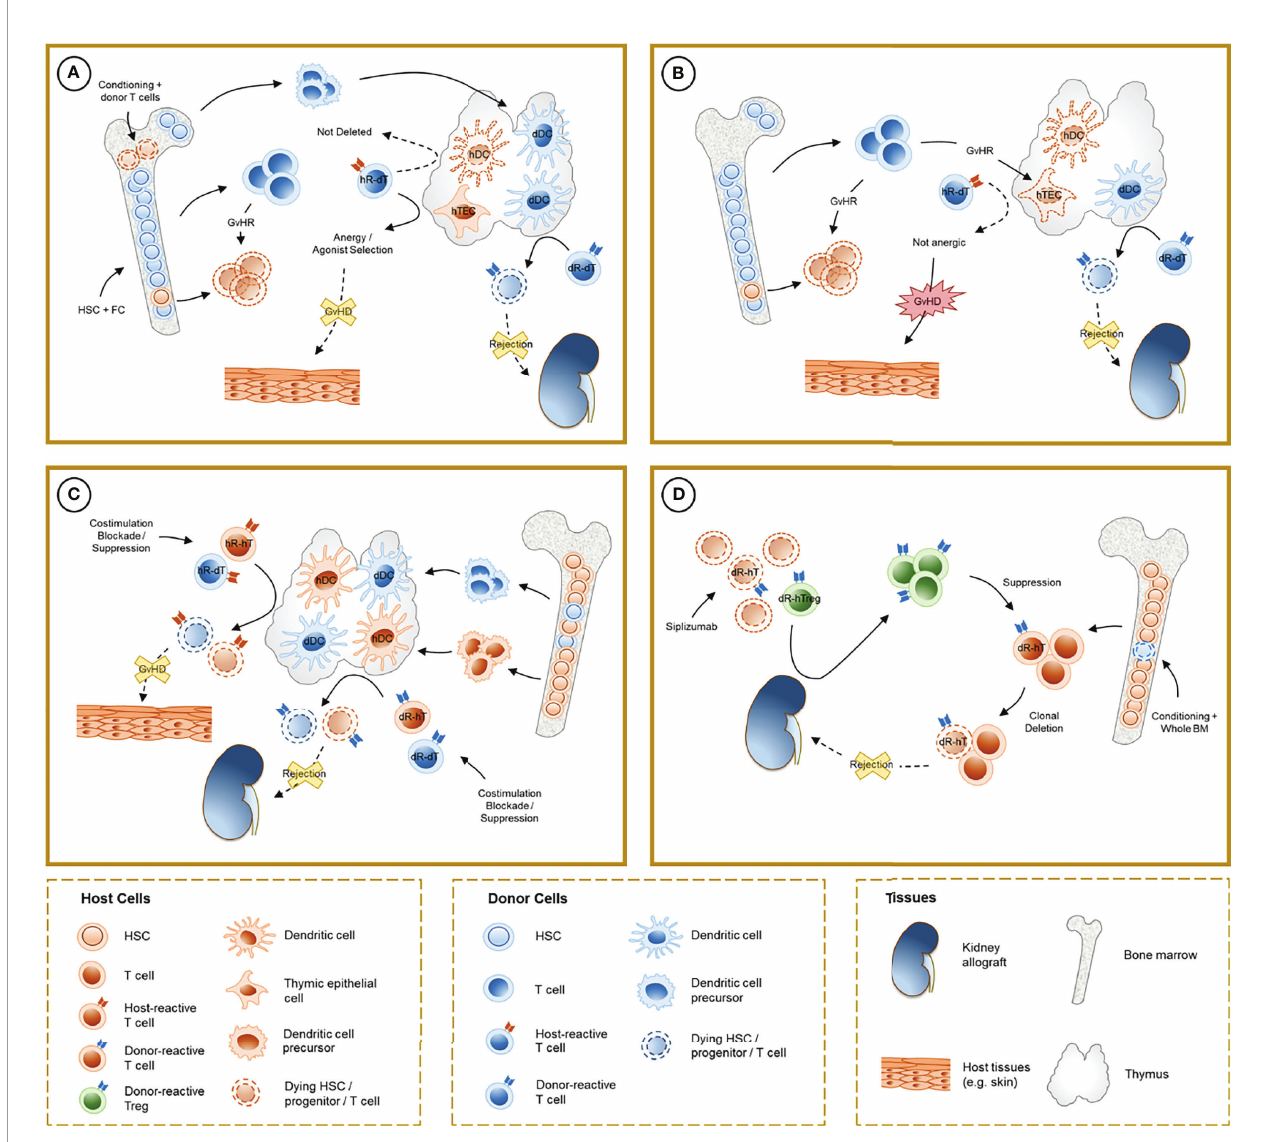
FIGURE 1 | Schematic representation of the mechanisms involved in chimerism-based tolerance to kidney allografts. (A) The induction of full-donor chimerism through hematopoietic stem cell (HSC) infusion along with facilitating cells (FC) after non-myeloablative conditioning results in destruction of host HSC, presumably by graft-versus- host reaction (GvHR) from infused donor T cells, and durable engraftment of donor hematopoietic precursors. After thymic repopulation by donor-derived dendritic cells (dDC), donor-reactive T cells from the donor (dR-dT) undergo clonal deletion in the thymus (central tolerance). Host-reactive donor T cells (hR-dT) are incompletely deleted, re fl ecting the absence of a self-renewing source of recipient APCs, but functional tolerance to the recipient may be achieved by a combination of mechanisms (anergy and selection of host-speci fi c Tregs) that involve recipient thymic epithelial cells (hTEC). (B) Destruction of hTEC and thymic structure by GvHR may cause failure of negative selection and precipitate graft-versus-host disease (GVHD). (C) In durable mixed chimerism, donor-derived precursors populate the host thymus and differentiate into DC (dDC) without depletion of their host-derived counterparts (hDC). Donor- and host-reactive T cells from both the donor and the host undergo negative selection, allowing allograft tolerance without GVHD. Treg-mediated suppression may also play a role in experimental regimens where clonal deletion is incomplete. (D) In CKBMT patients receiving a siplizumab-based conditioning regimen and unprocessed bone marrow, transient mixed chimerism promotes peripheral tolerance. Host Tregs are relatively spared from global T cell depletion, and donor-reactive host Tregs (dR-hTreg) are expanded by antigenic pressure from the graft. Emerging donor- reactive T cells, which are not subjected to central deletion, are suppressed by dR-hTreg and ultimately undergo peripheral deletion over